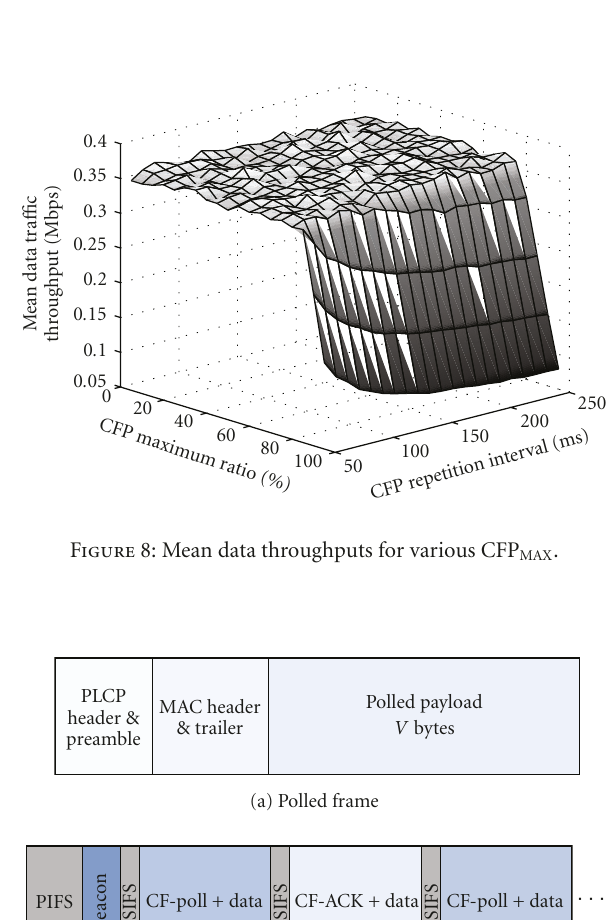
Figure 7: CDFs of voice packet delays at 70% CFP MAX .